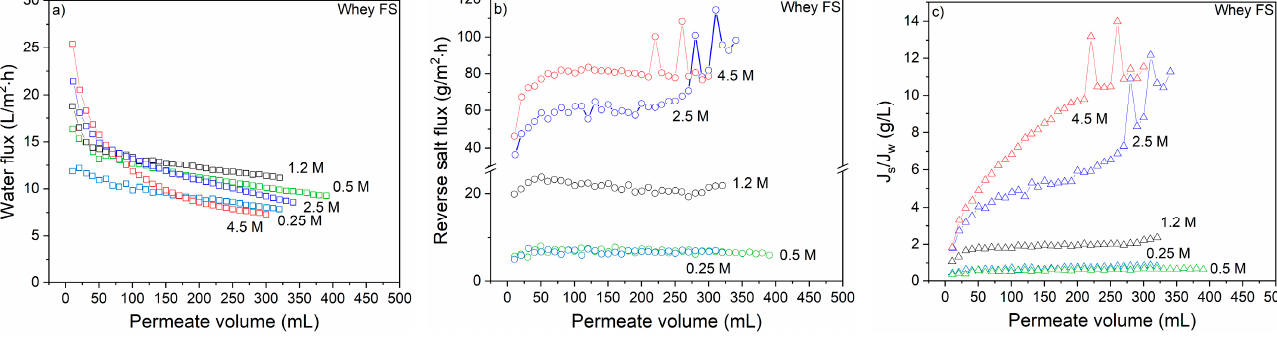
Figure 3. The effect of draw solution concentration on the ( a ) water flux; ( b ) reverse salt flux and ( c ) specific reverse salt flux during whey filtration as a function of permeate volume. FS: 8.75 g/L whey; Osmotic pressure: 0.1 bar. Average values represent two runs.